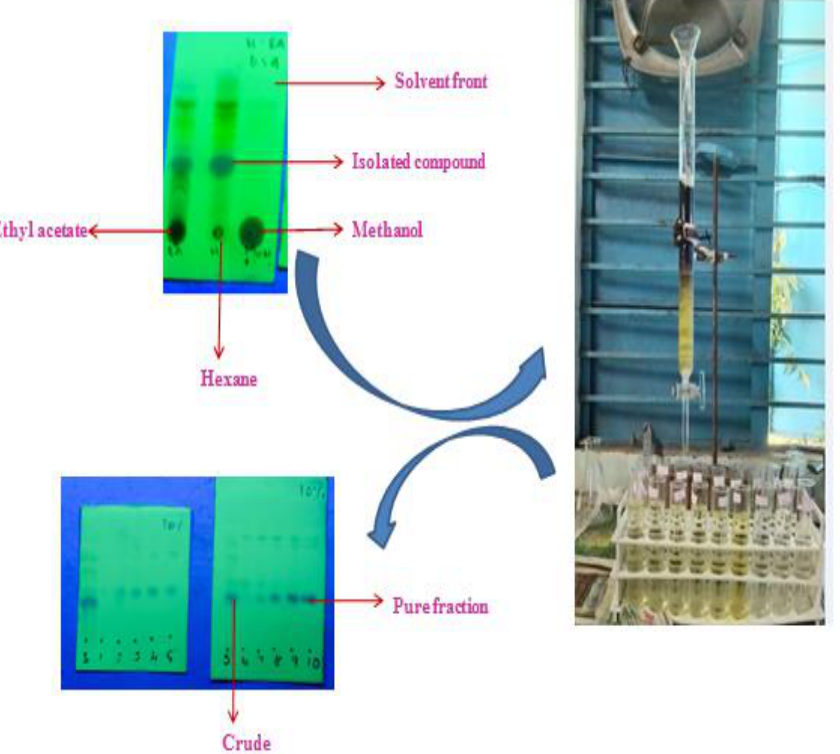
Figure 1. Separation of compound by column chromatography and analysis of TLC studies.